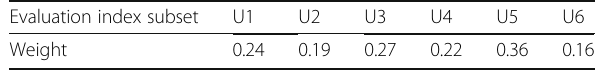
Table 1 Weight of evaluation index subset of logistic project Evaluation index subset